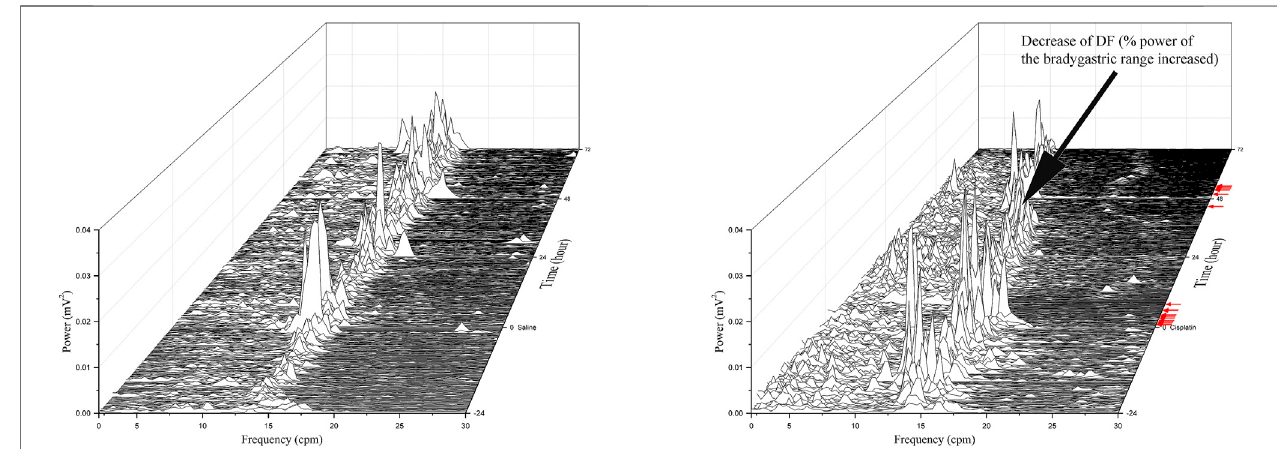
FIGURE 4 | Running spectrum analysis of gastric myoelectric activity in vehicle- (A) and cisplatin-treated (B) Suncus murinus . This cisplatin-treated animal exhibited emesis after a latency of 37.3 min, and it had 12 and 7 episodes of emesis during the 0 – 24 h and 24 – 72 h periods, respectively. Note the decrease in the DF following cisplatin administration. Red arrows indicate where emetic events occurred after treatment with cisplatin.